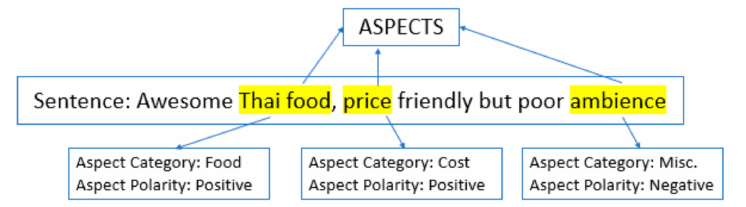
Figure 2. A sample sentence for explaining